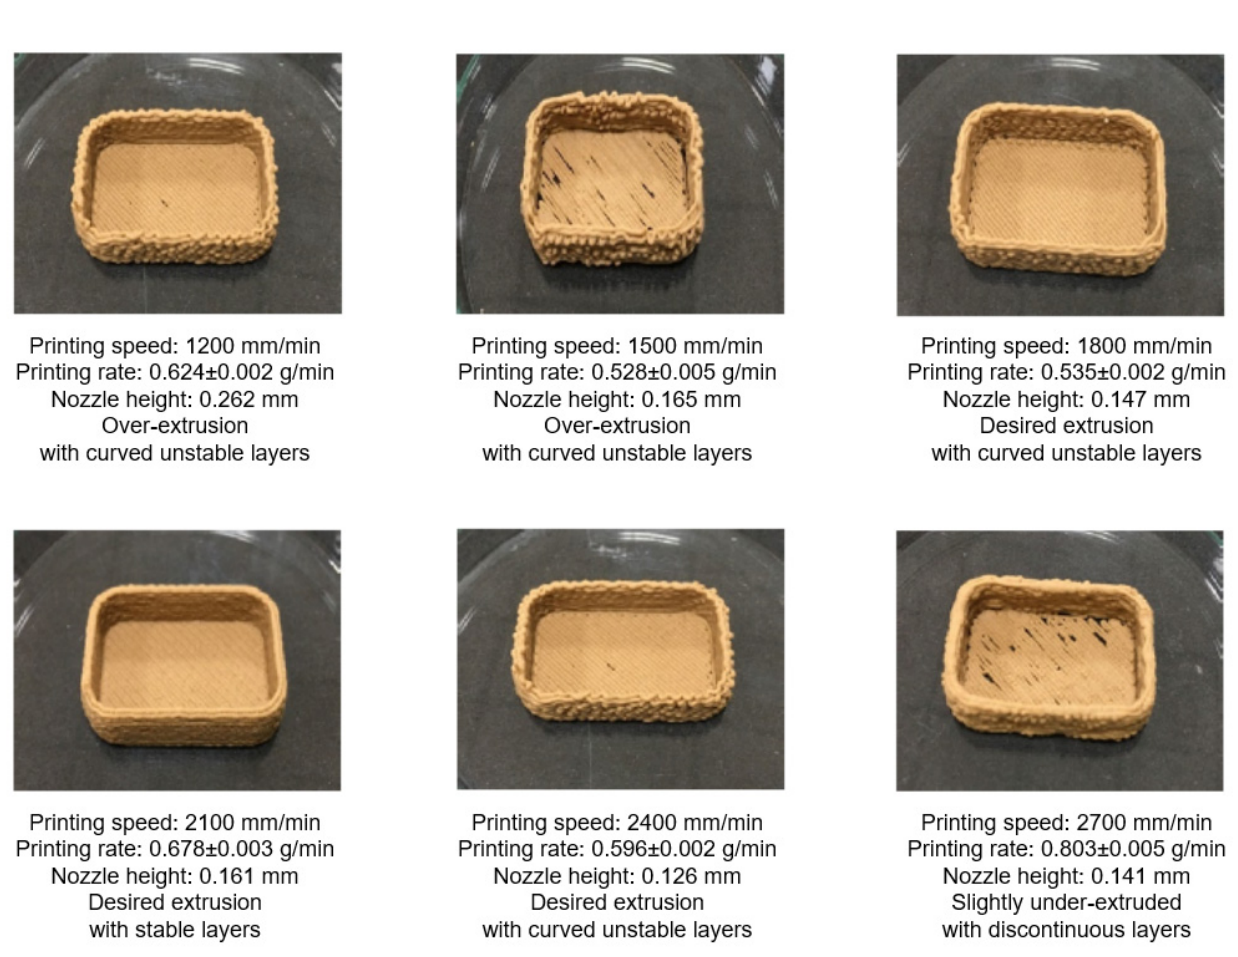
Figure 8. Optimization of material supply for 3D-printed food casings from milled rice husk with 1% guar gum using a nozzle diameter of 0.82 mm at 300 rpm motor speed and 4 bar pressure “Reprinted/adapted with permission from Ref. [65]. Copyright © 2020, Springer Nature”